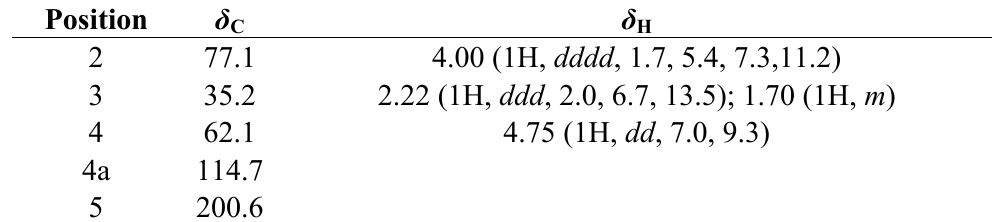
Table 1. 1 H- (400 MHz) and 13 C-NMR (100 MHz) data of compound 1 (in CDCl ppm, J in